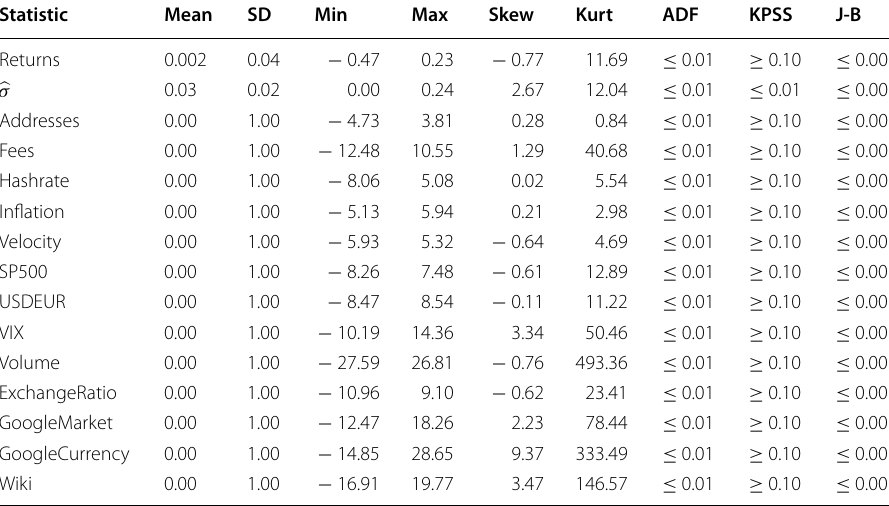
Table 4 Descriptive statistics of the BTC final sample